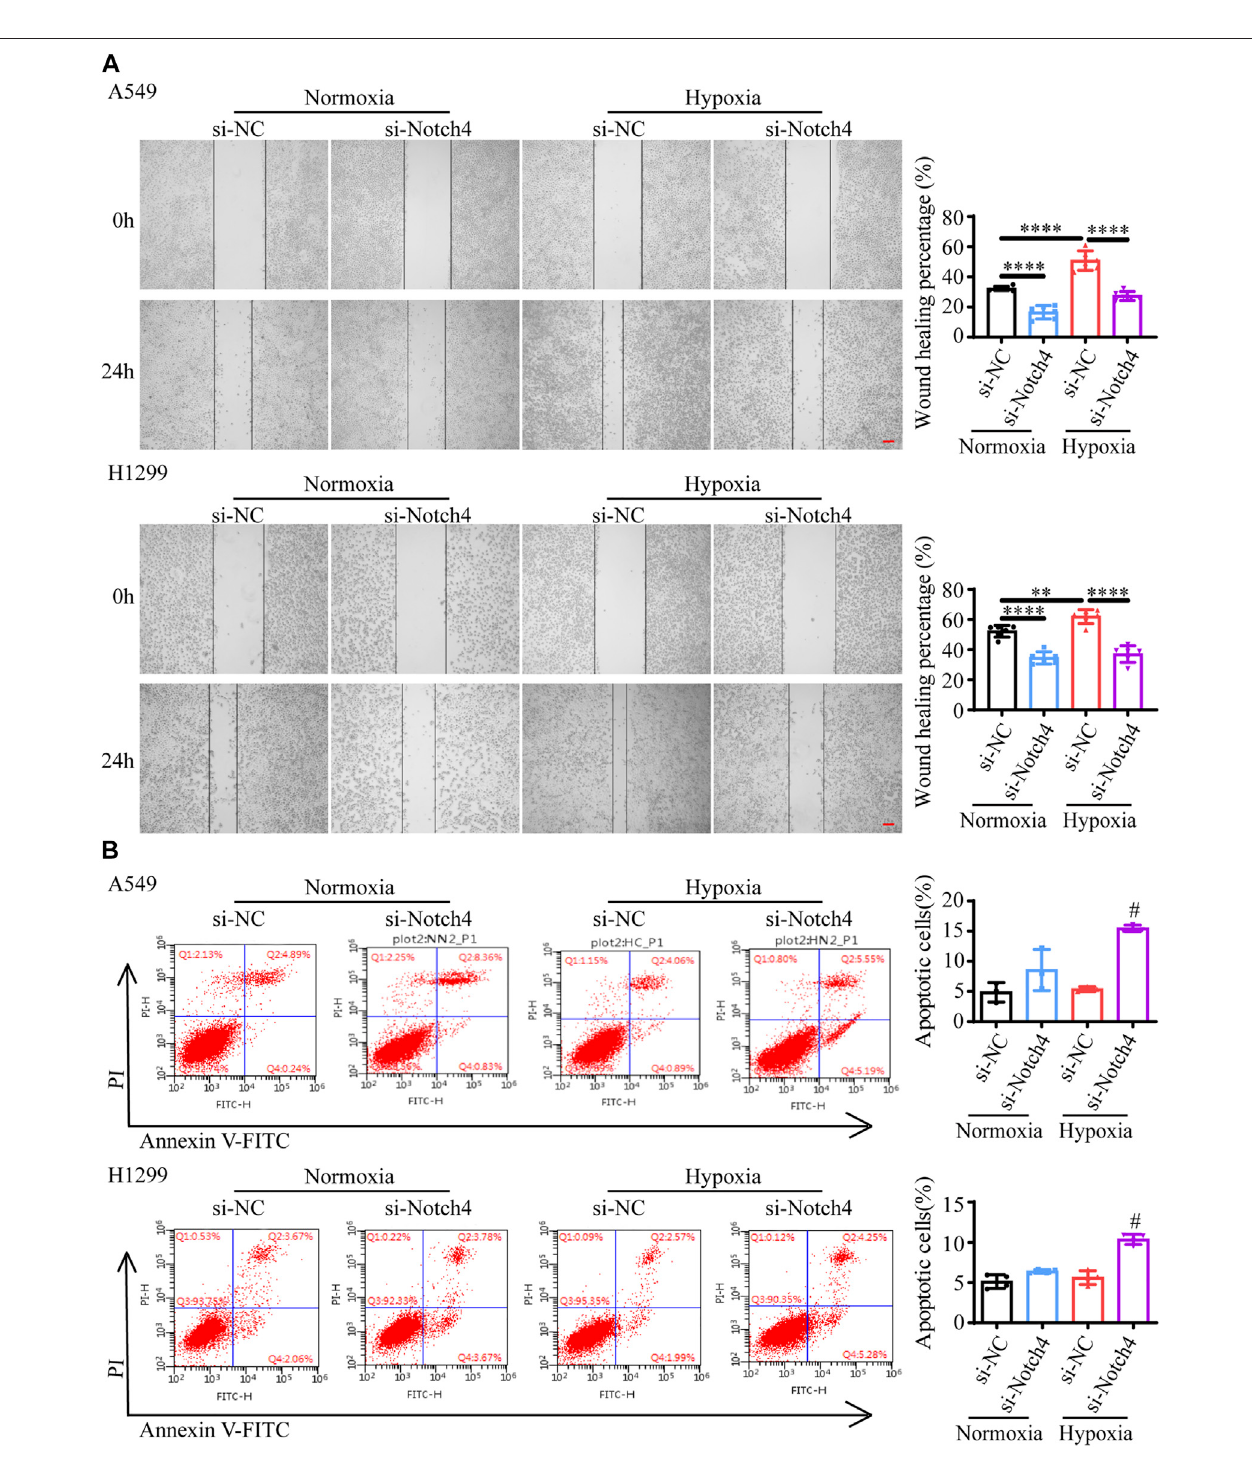
FIGURE 4 | Notch4 is involved in the regulation of cell migration and apoptosis in A549 and H1299 cells exposed to hypoxia. (A) Wound healing assay was performed in A549 and H1299 cells. ( n (cid:2) 4). Magni fi cation, × 40; Bar, 200 μ m. (B) Cell apoptosis was assessed by Annexin-V/PI staining. ( n (cid:2) 3). Analyses of apoptosis including early apoptosis (Annexin-V positiveand PI negative) and late apoptosis (Annexin-V positive and PI positive) were shown. Data were presented as means ± SD. * p < 0.05, ** p < 0.01, **** p < 0.0001, comparison with normoxic cells treated with si-NC; # p < 0.05, comparison with hypoxic cells treated with si-NC. si-NC, negative control short interfering RNAs (siRNA); si-Notch4, the siRNA against Notch4; PI, propidium iodide.